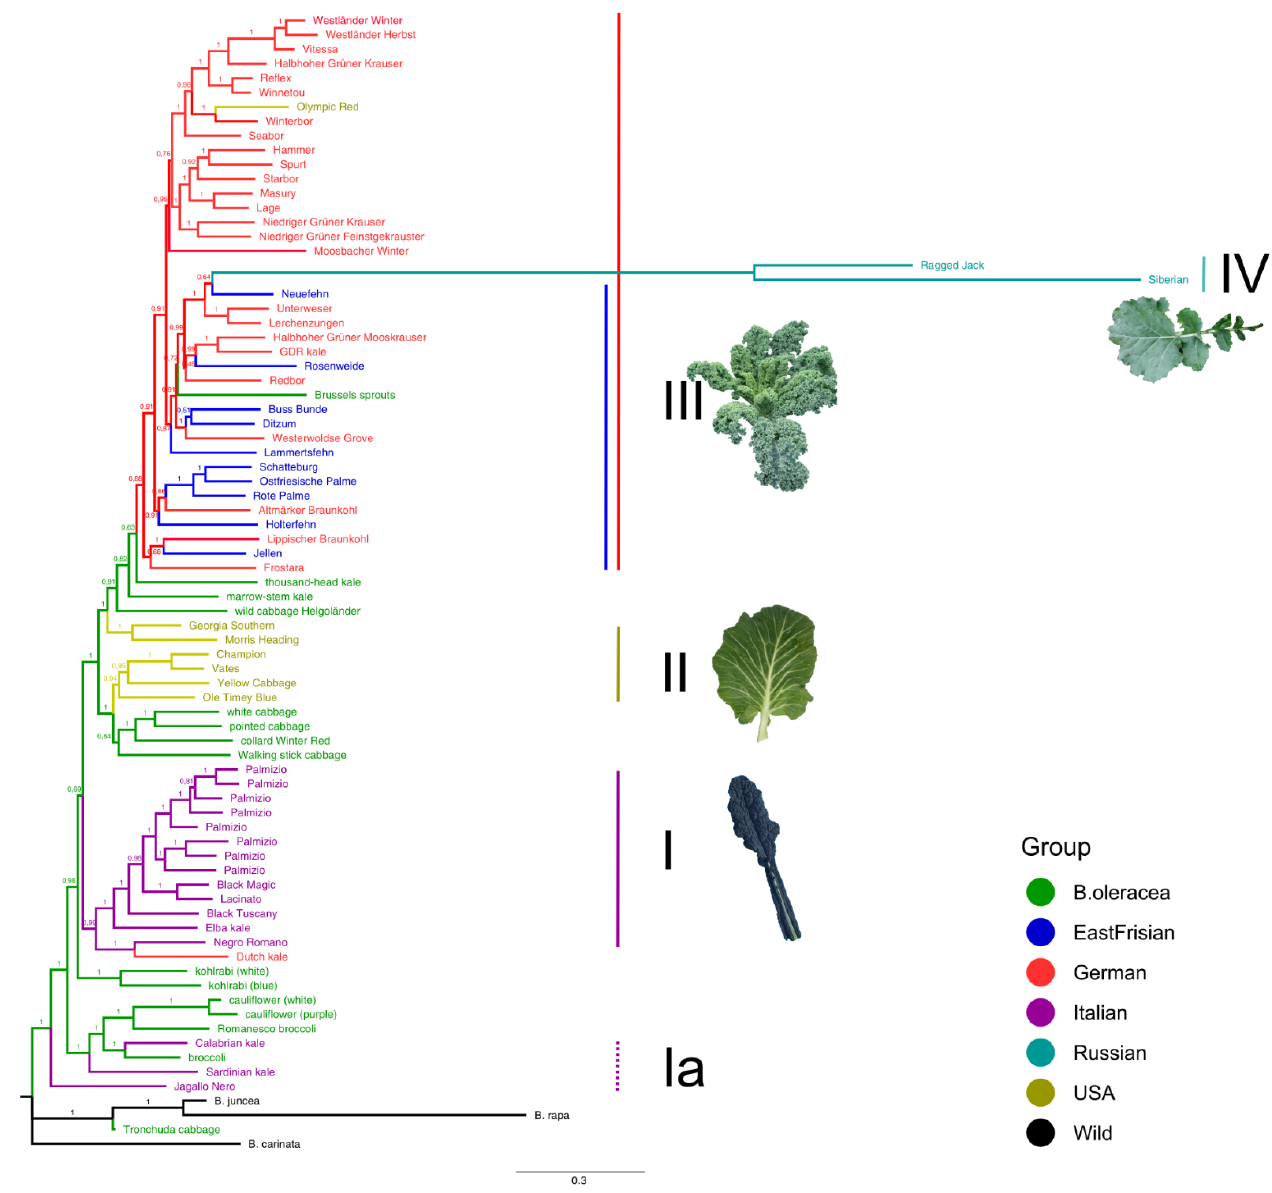
Figure 6. Bayesian inference phylogeny of kale and cabbage varieties, based on the SNP data from the filtered dataset. Sample names are color coded according to their origin. Numbers above branches are Bayesian posterior probabilities.